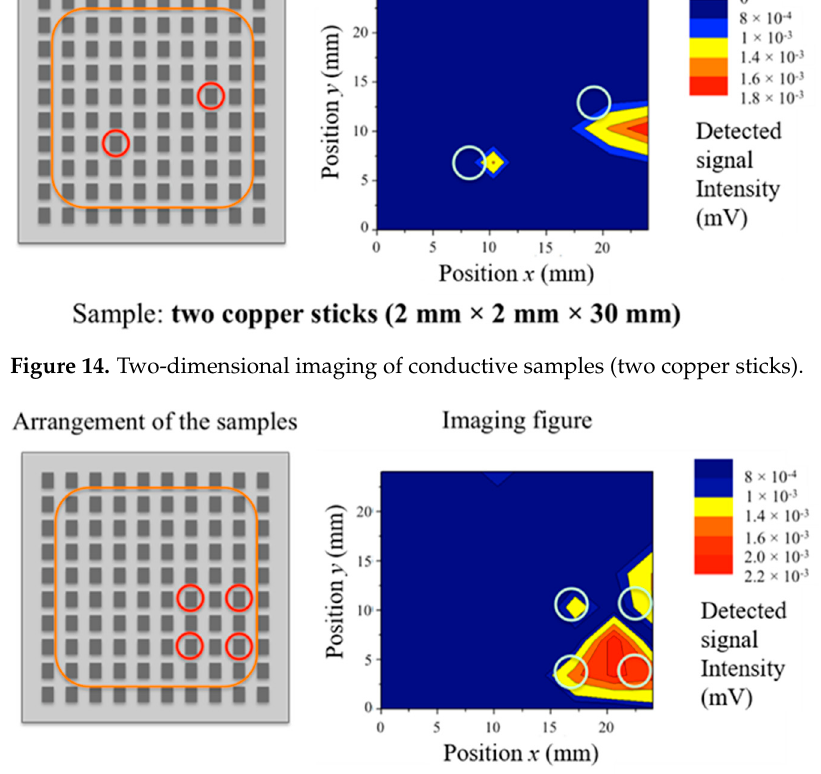
Figure 16. The two-dimensional imaging of dielectric samples (an alumina stick).